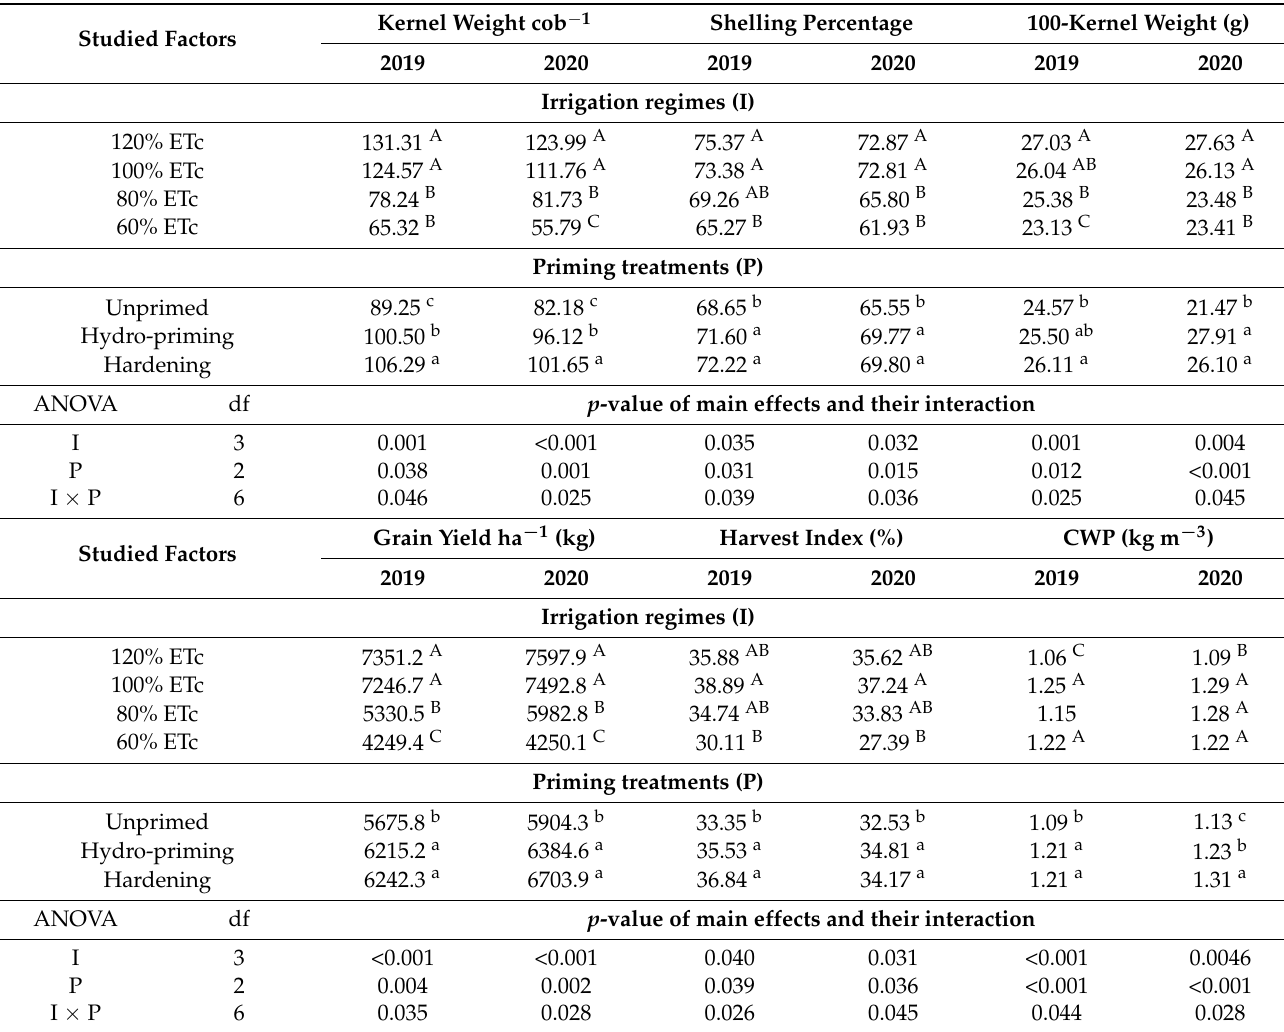
Table 5. Impact of irrigation regimes and seed priming treatments on kernel weight per cob, shelling percentage, 100-kernel weight, grain yield, harvest index and crop water productivity (CWP) during the growing seasons of 2019 and